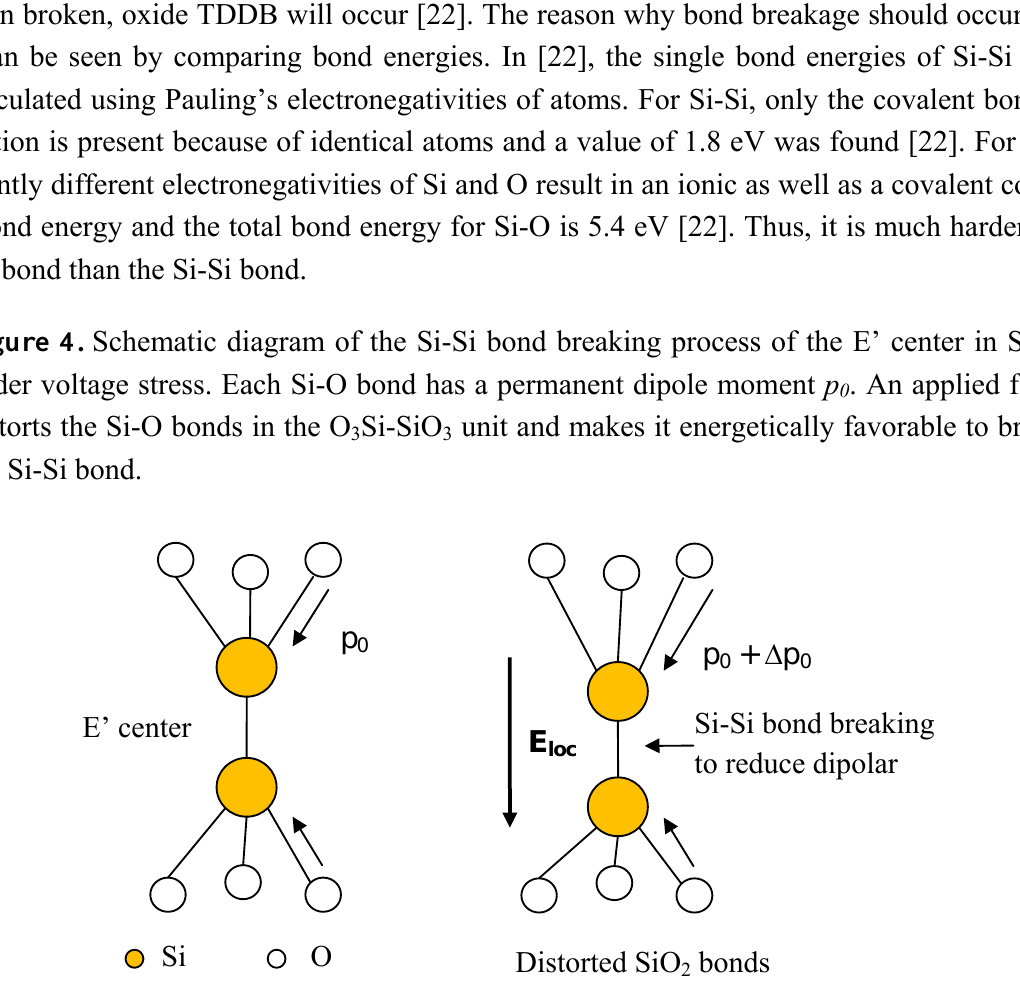
2 . An applied field 0